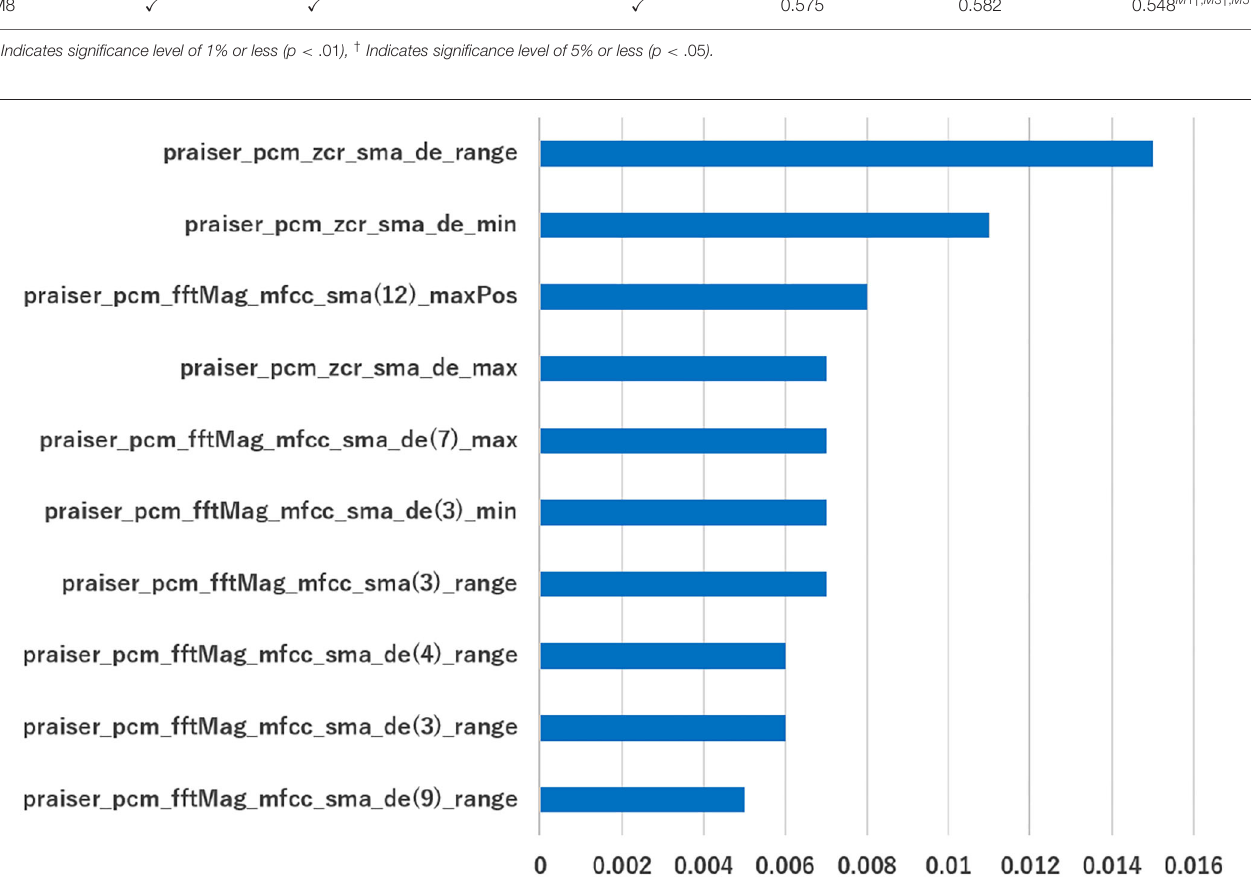
frame of the praiser’s voice. The value of this feature increases when it is voiceless sound. This indicates that voiceless sounds